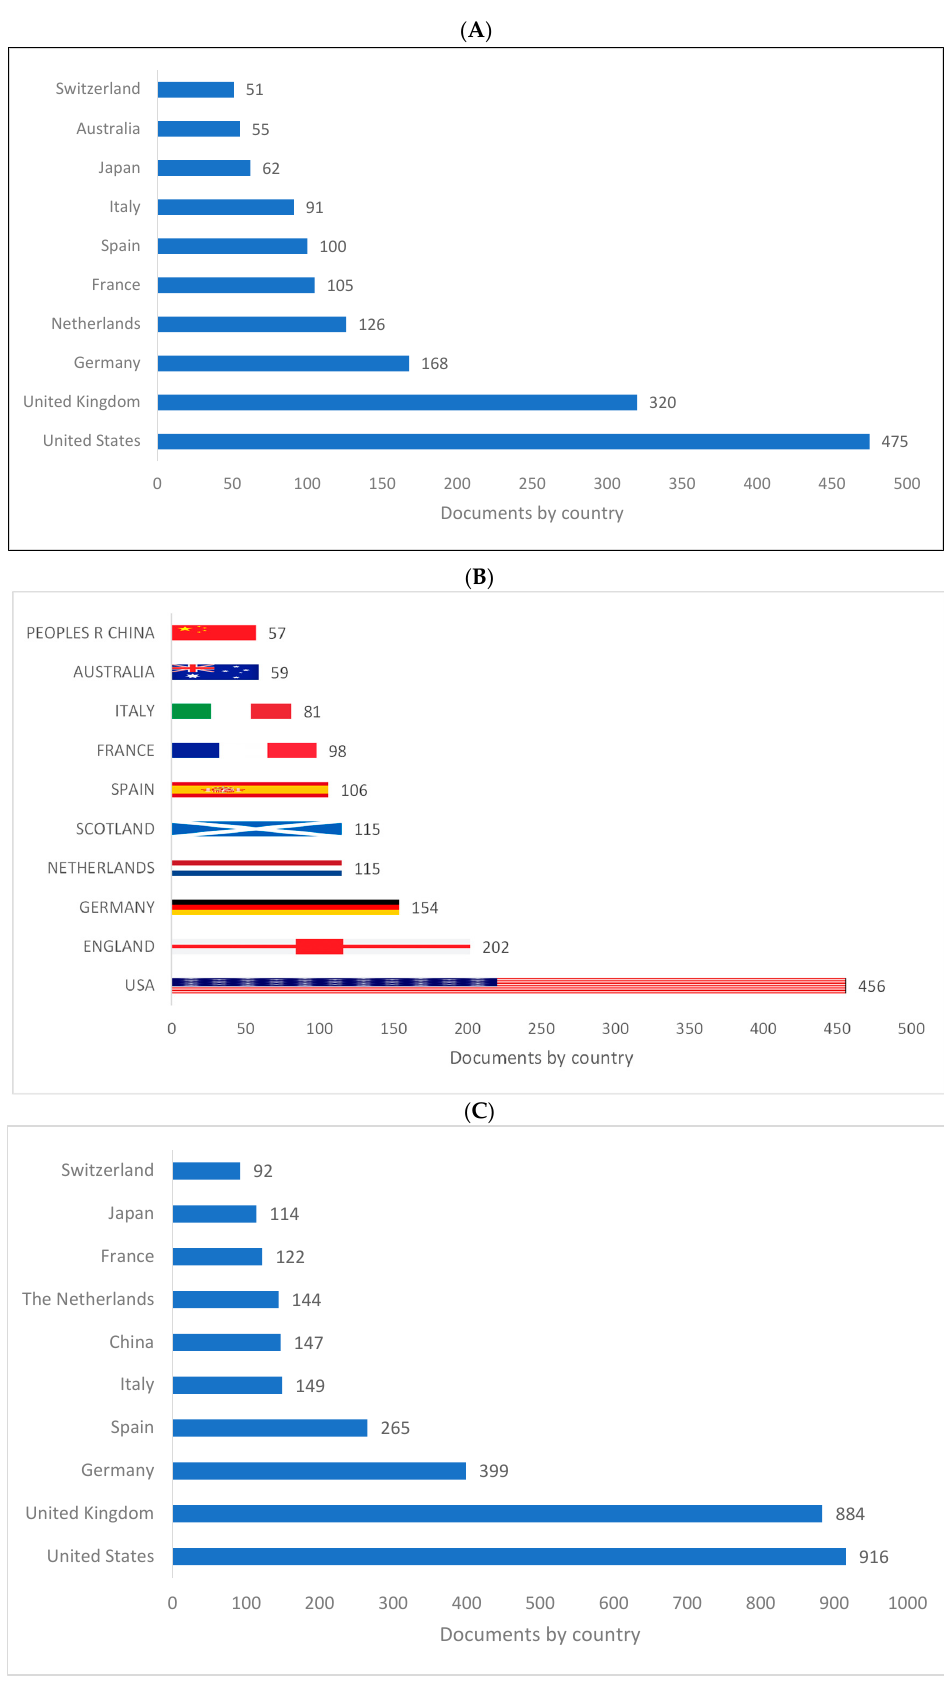
Figure 2. Knowledge production size in biolinguistics by country. ( A ) (Scopus), ( B ) (WOS), ( C ) (Lens).